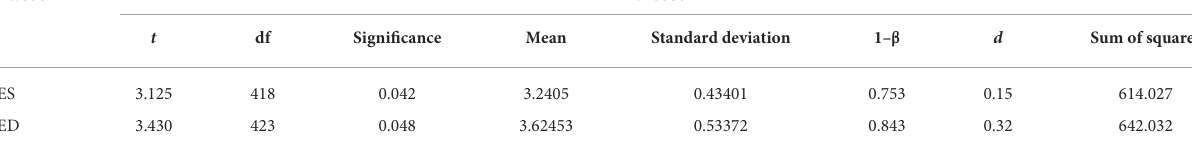
TABLE 3 Statistical table of independent t -test results of CLR-based business environment optimization, ES, and ED. Factor t -test